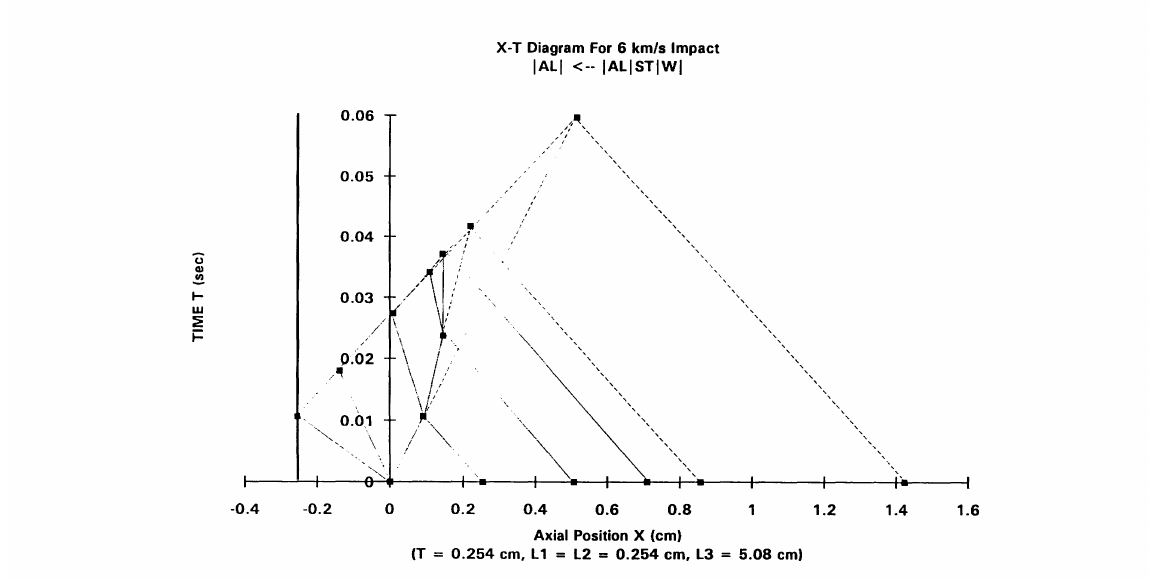
FIGURE 3 Movement of rarefaction wave R4 and shock wave SI specific